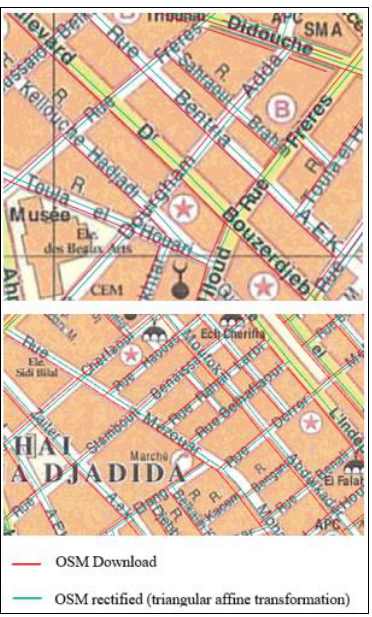
Figure 12. OSM network before and after geometric correction using triangular affine transformation